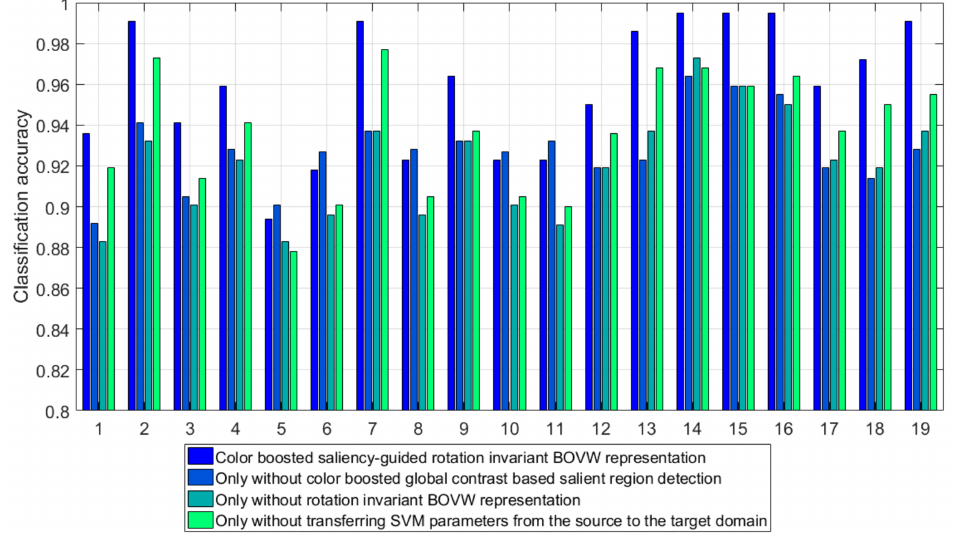
Figure 12. Producers’ accuracies with the WHU-RS dataset for four different methods in Table 3. The class labels are assigned as follows: 1 = airport, 2 = beach, 3 = bridge, 4 = commercial, 5 = desert, 6 = farmland, 7 = football field, 8 = forest, 9 = industrial, 10 = meadow, 11 = mountain, 12 = park, 13 = parking, 14 = pond, 15 = port, 16= railway station, 17 = residential, 18 = river, and 19 = viaduct.